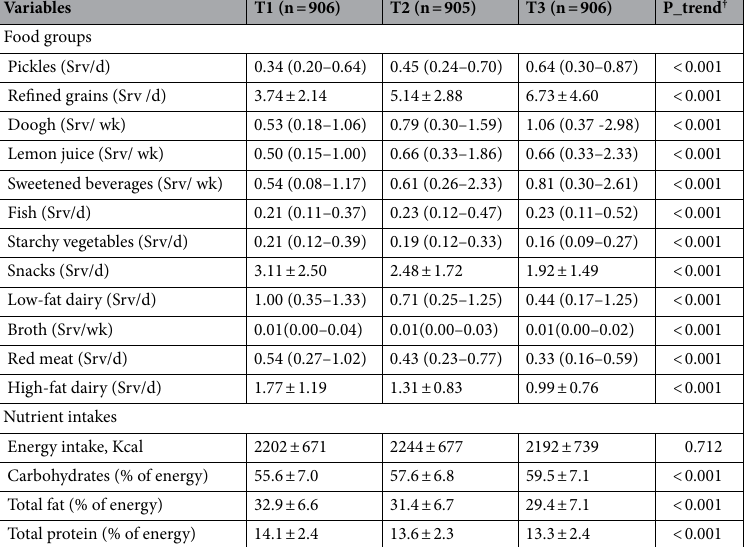
Table 2 shows the intake of food groups and nutrients according to the tertile of the DIR. Across tertiles of DIR, the starchy vegetables, snacks, low-fat dairy, broth, red meat, high-fat dairy, total fat, and total protein decreased, however, dietary intake of pickles, refined grains, doogh, lemon juice, sweetened beverages, fish, and carbohydrates increased. There were no significant differences in other variables across the tertile of DIR.